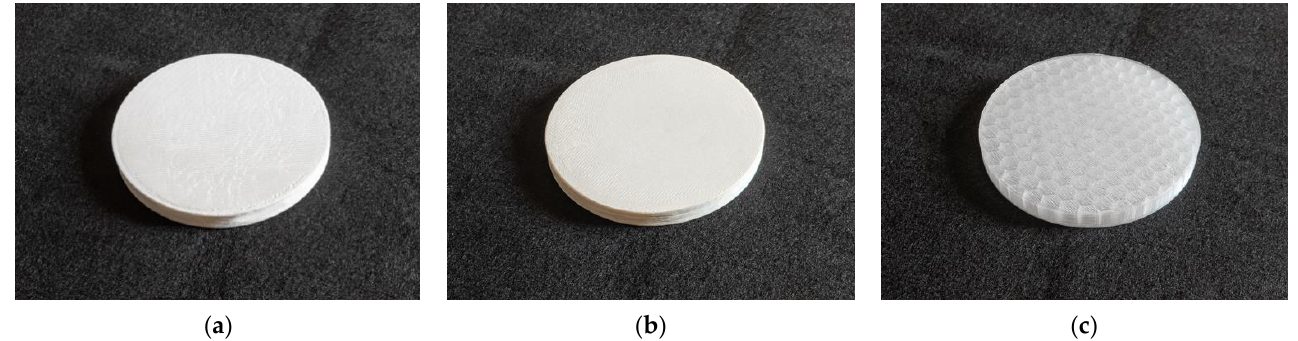
Figure 13. The specimens made through the 3D printing process: ( a ) ABS [68]; ( b ) PETG [69]; ( c ) PLA [70].